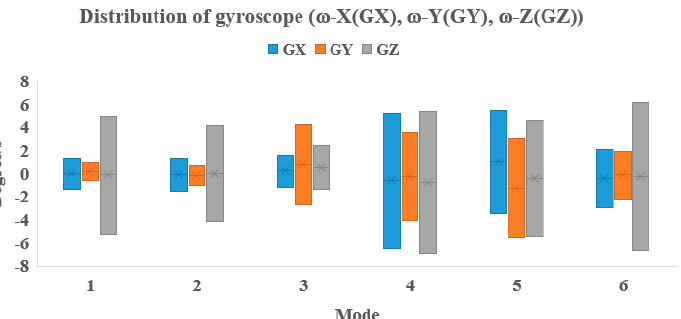
Figure 7. Distribution of gyroscope parameters for six modes (1 = Bicep, 2 = Deltoid, 3 = Tricep, 4 = Shoulder, 5 = Squat, 6 = Side and lunge).